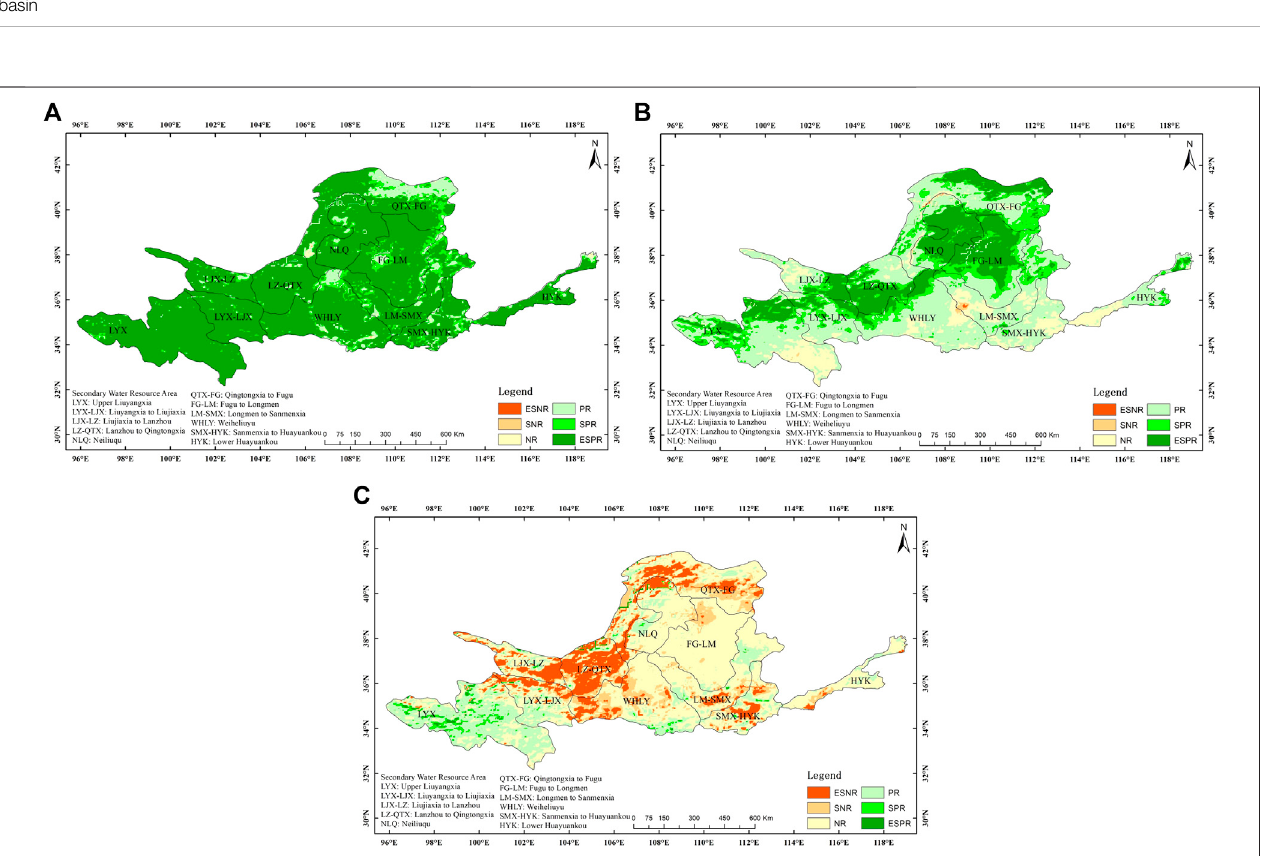
FIGURE 8 | Correlation between NPP and AMT (A) , AP (B) , and ASH (C) .